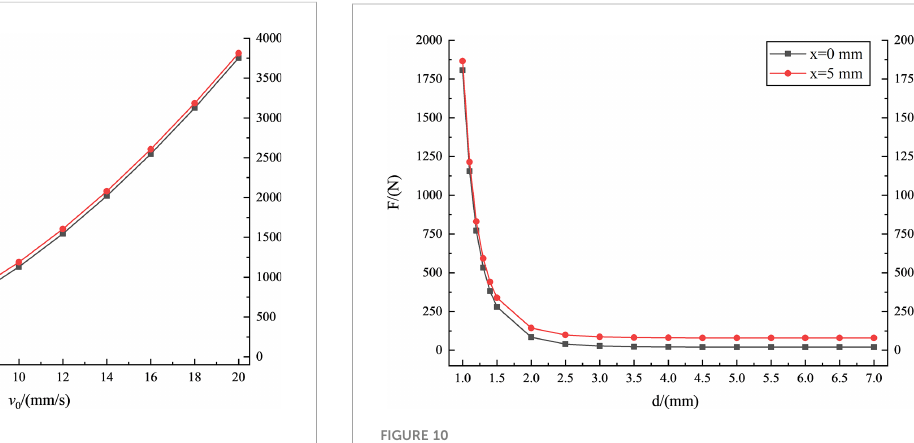
FIGURE 10 In fl uence of inner diameter of pressure pipe on pressing